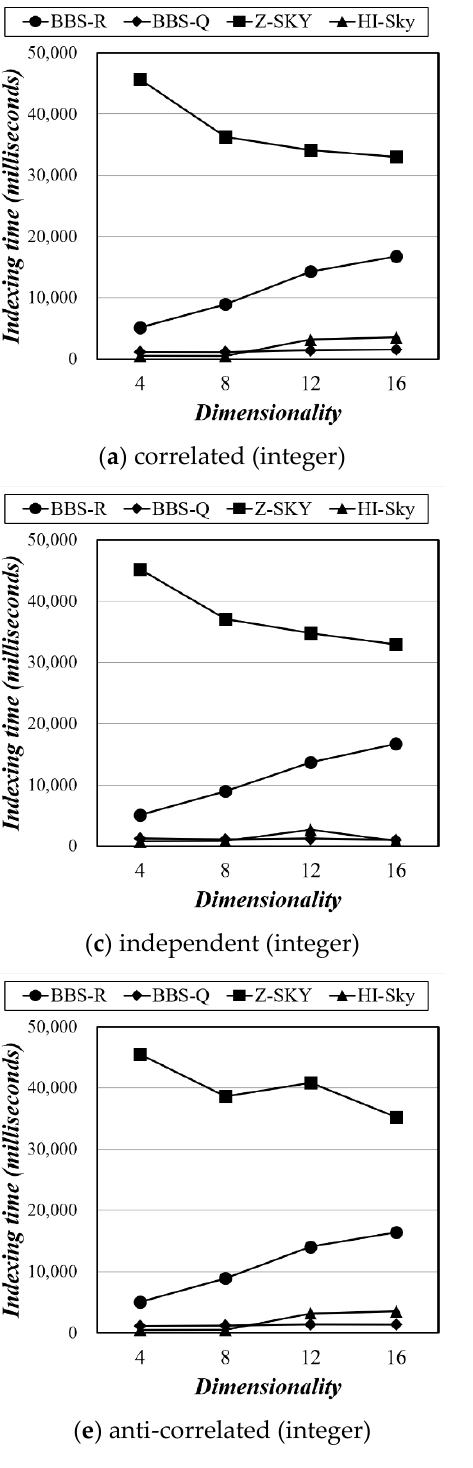
Figure 6. Indexing time (1 Million).